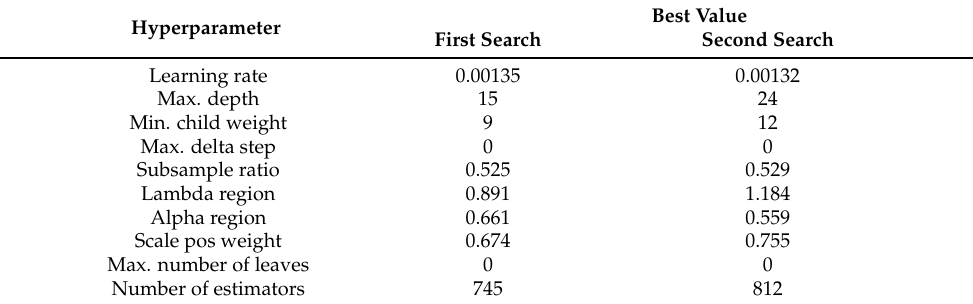
Table 2. Hyperparameter optimal